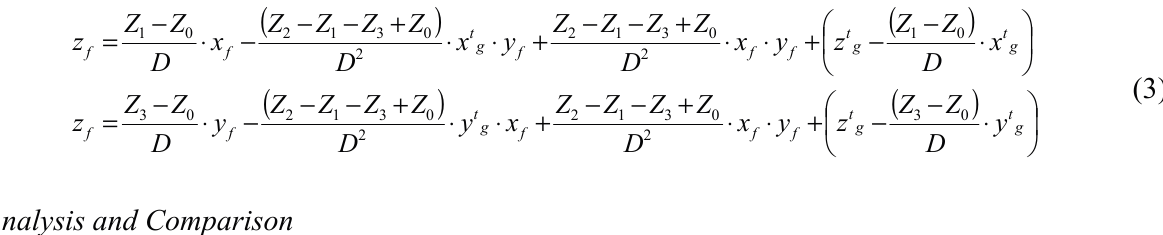
Figure 7. Schematic explanation of least squares target function minimization via perpendicularity constraints in TIN triangular-domain, ensuring closest